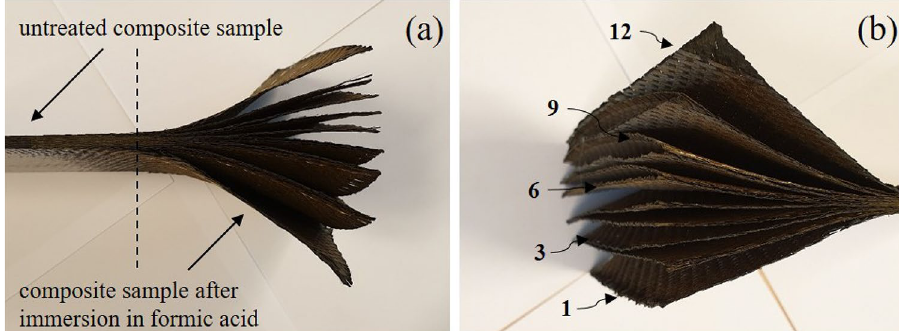
Figure 1. Illustration of separated CF layers after partial immersion in formic